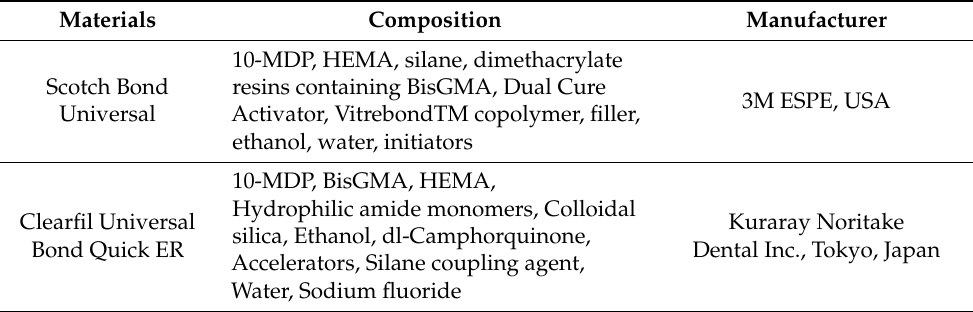
Table 1. Composition of the one-step self-etch adhesives (1-SEAs) tested in this